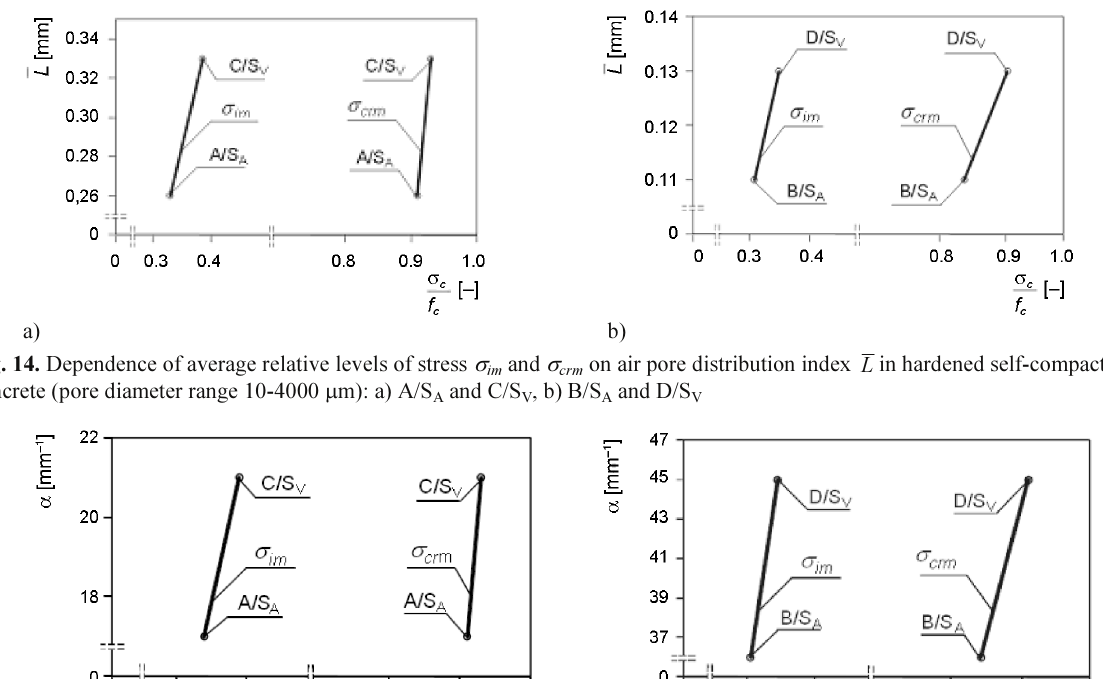
Fig. 13. Dependence of average relative levels of stress σ im and σ crm on total porosity p in hardened self-compacting concrete (pore radius range 5–7500 nm): a) A/S A and C/S V ; b) B/S A and D/S V